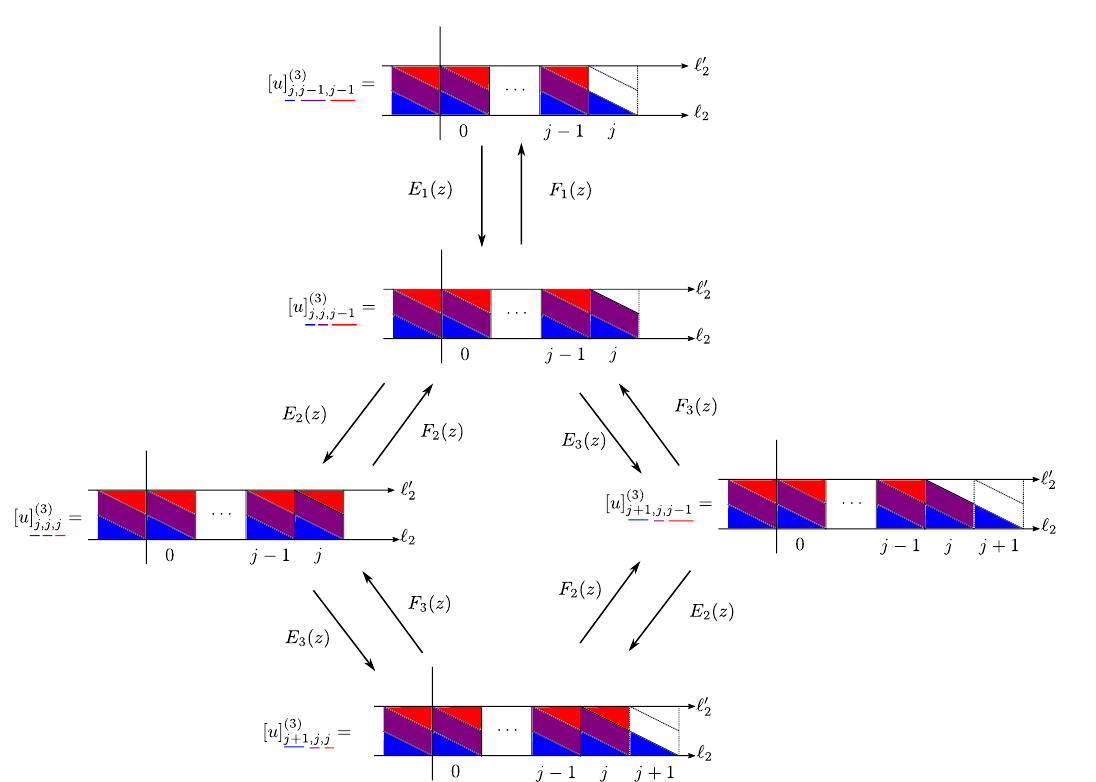
Figure 45. Action of the generators E s ( z ) , F s ( z ) in one-dimensional crystal representation of ‘ 2